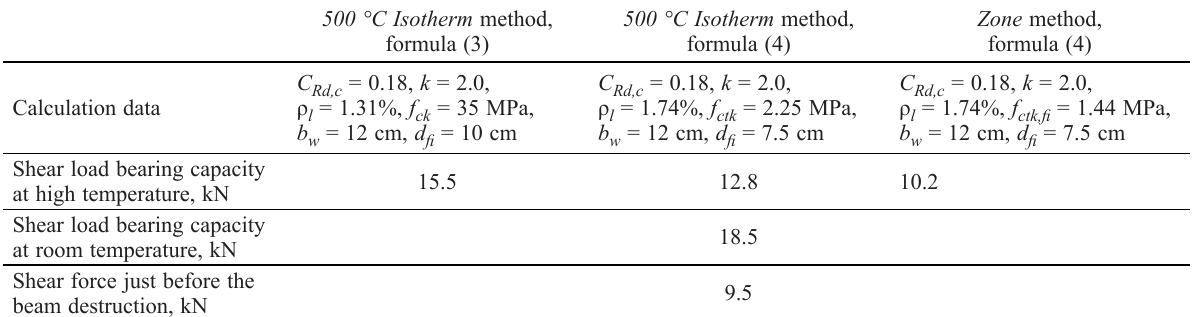
Table 3. Calculation data and calculated shear load bearing capacity of the cross-section situated in the middle part of the